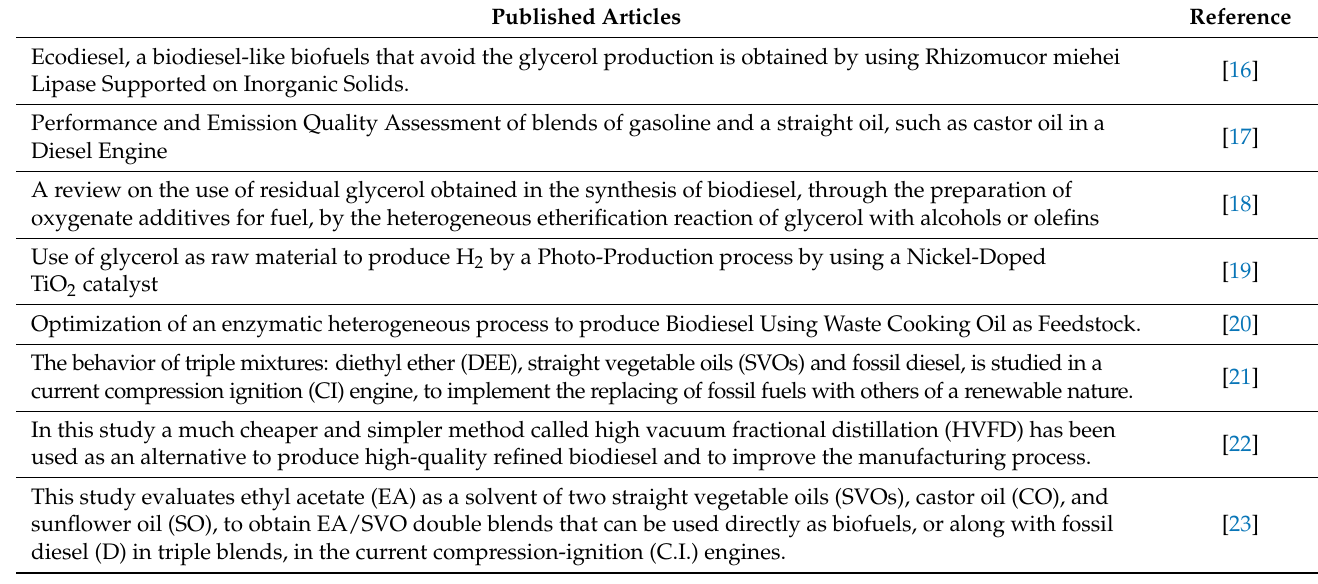
Table 1. Summary of the articles published in the Special Issue Optimization of Biodiesel and Biofuel